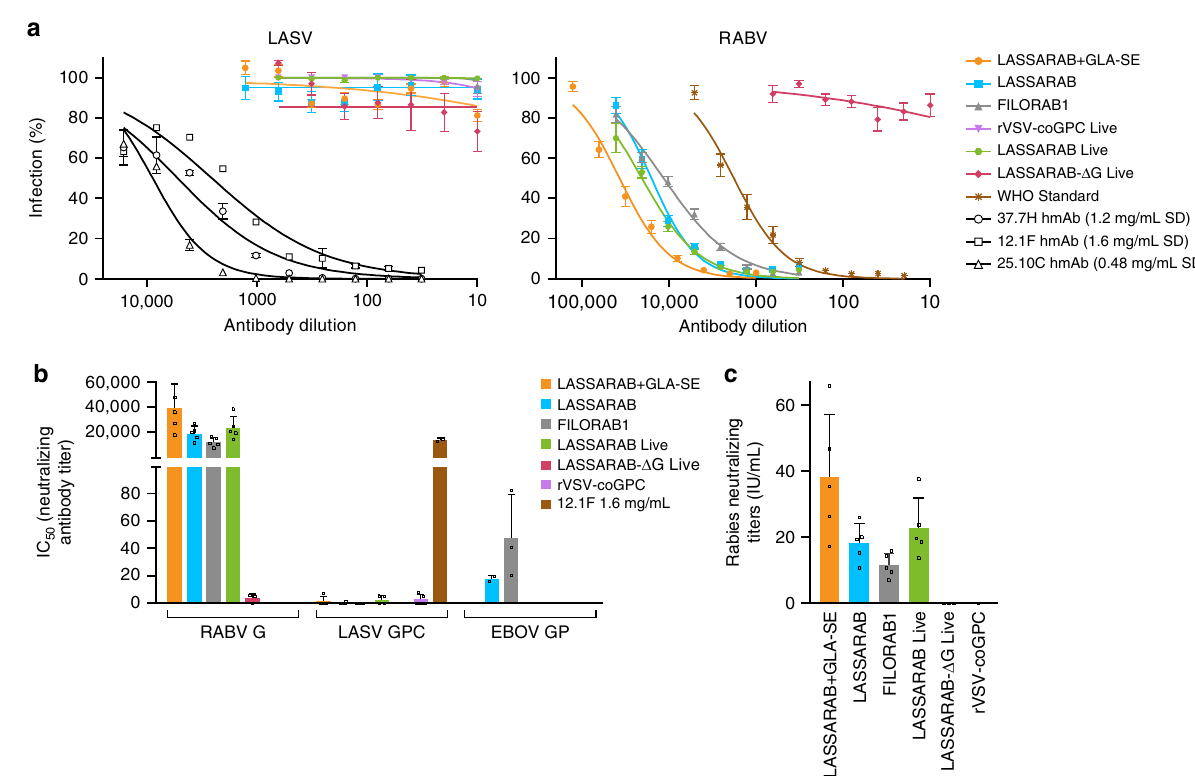
Fig. 5 Virus neutralization antibody titers. Day 42 sera from immunized mice was incubated with pseudotyped rVSV- Δ G-NL-GFP. a rVSV- Δ G-NL-GFP was pseudotyped with either RABV-G, LASV-GPC, or EBOV-GP to assay for RABV-G, LASV-GPC, or EBOV-GP NAb titers, respectively. 12.1F, 37.7H, and